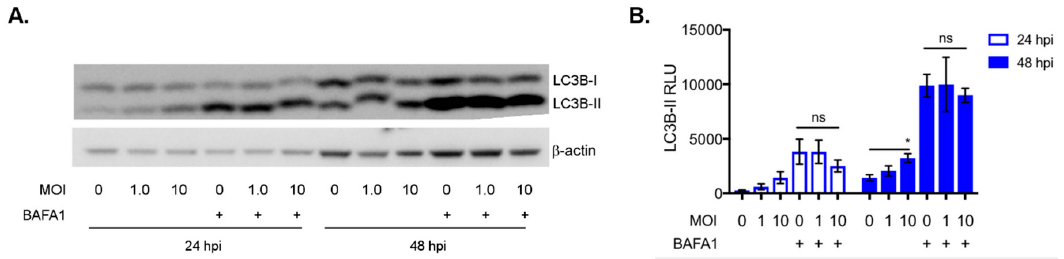
Figure 4. ABLV infection and autophagy activation in primary black flying fox brain cells. ( A ) Western blot for LC3B in primary black flying fox brain (PaBr) cells following 24 and 48 hpi with wt-ABLV MOI indicated. BAFA1 treatment (400 nM) was used as a control for blocking autophagic flux. ( B ) Quantification of LC3B-II levels ( β -actin normalized) relative light units (RLU) from cells infected in ( A ). All data are representative of three independent experiments, mean ± SEM and * p < 0.05 ANOVA (two-way), and Tukey’s multiple comparison test (48 hpi MOI 0 vs. MOI